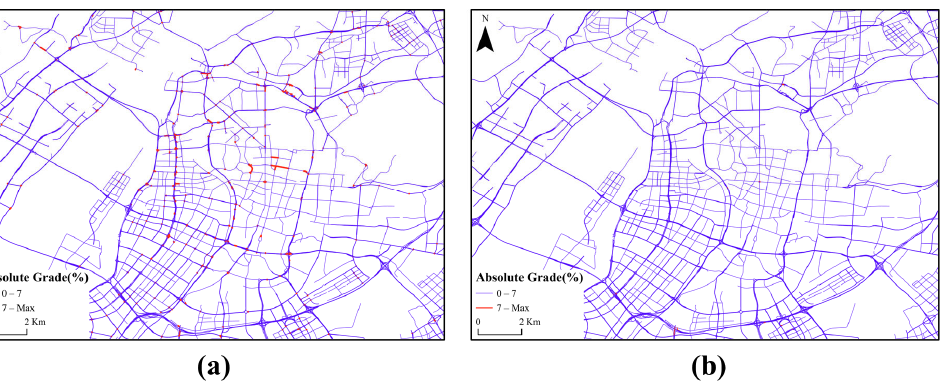
Figure 10. The spatial distribution of absolute grade ( a ) in the uncorrected road network; ( b ) in the corrected road network.